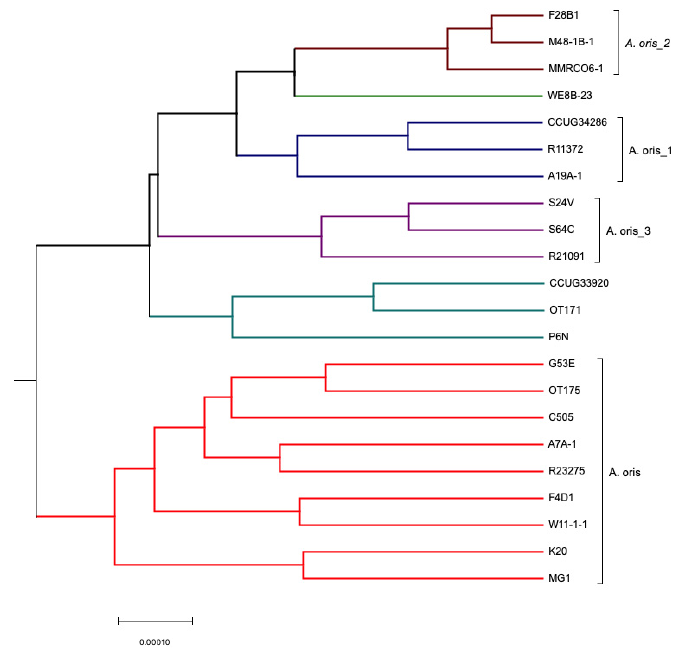
Figure 2. ClonalFrame analysis of A. oris isolates using whole Actinomyces spp. genomes. * Six independent groups were observed, known as A. oris , A. oris_1 , A. oris_2 , A. oris_3 , and two independent clusters.